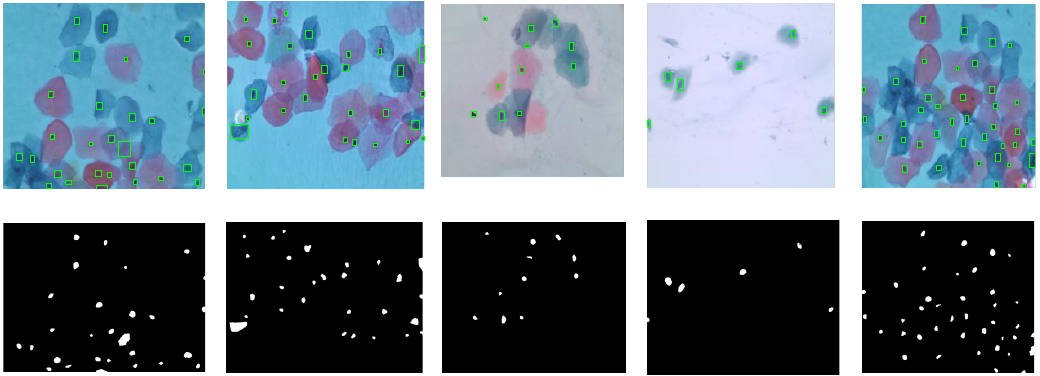
Figure 11. Nuclei detection in multi-cells Pap smear images.